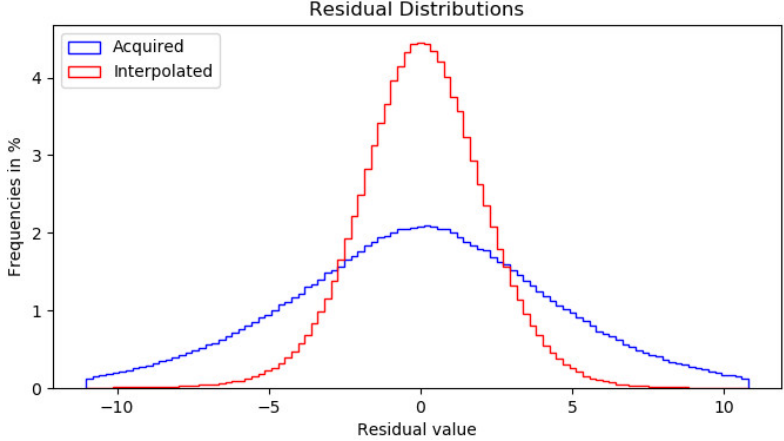
Figure 8. Residual frequencies for interpolated and acquired residuals.